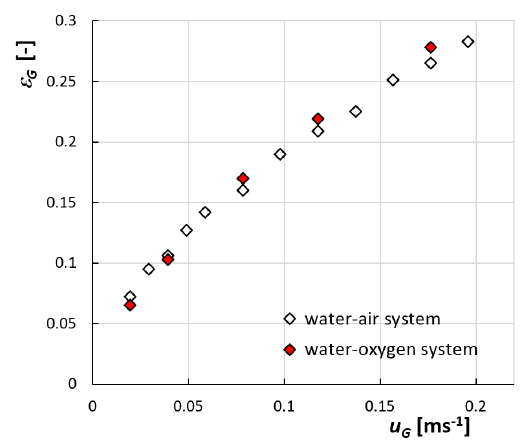
Figure 3. Effect of gas phase composition on the dependence of gas hold-up on gas superficial velocity.